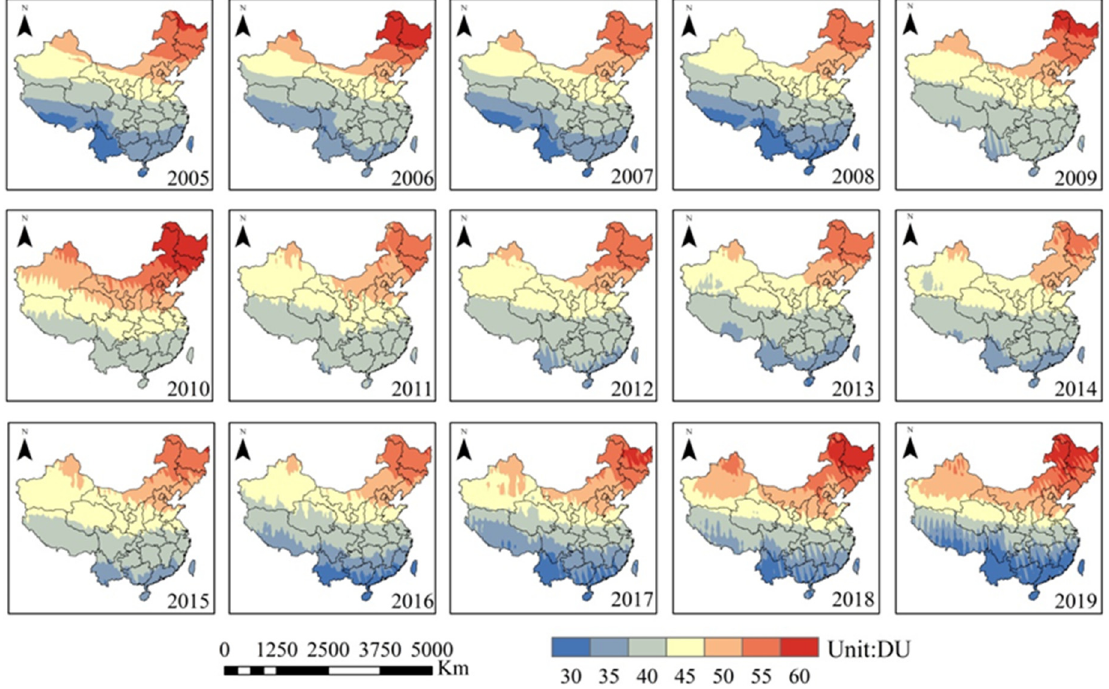
Figure 4. The inter-annual spatial variations of TCO concentration in China.